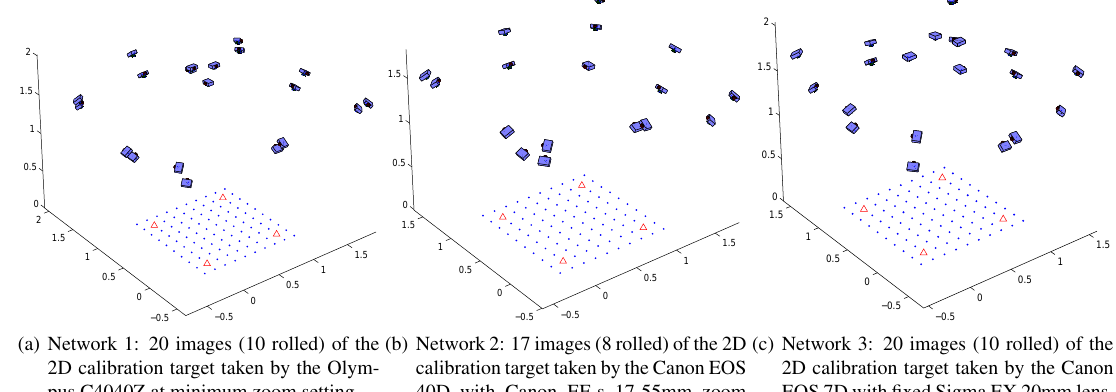
(b) Network 2: 17 images (8 rolled) of the 2D calibration target taken by the Canon EOS 40D with Canon EF-s 17-55mm zoom lens at 17mm.